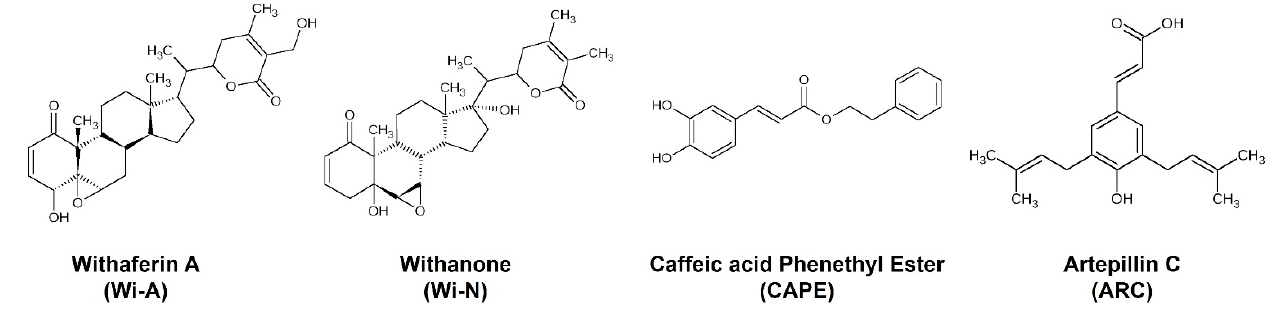
Figure 1. The 2D pictorial representation of natural compounds: Withaferin A (Wi ‐ A), Withanone (Wi ‐ N), Caffeic Acid Phenethyl Ester (CAPE) and Artepillin C (ARC).